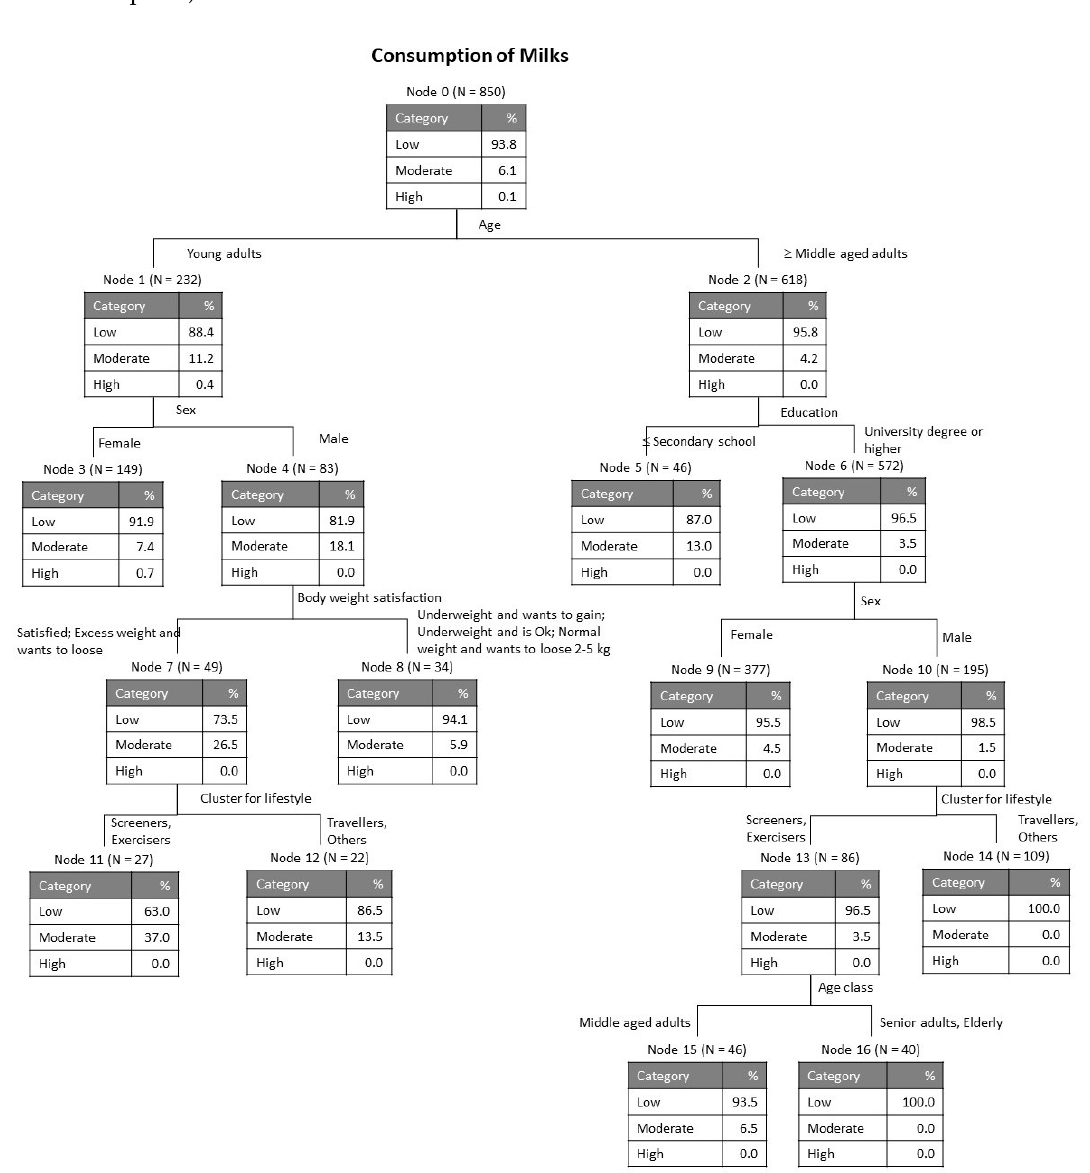
Figure 1. Tree classification for consumption of milks.